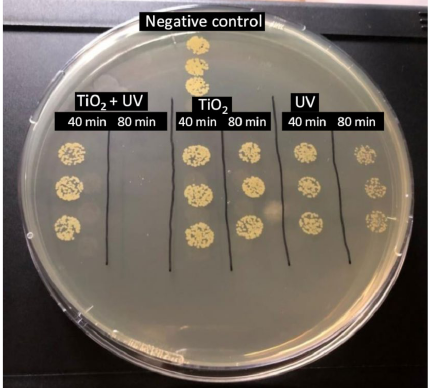
Fig. 6 M. luteus capability to form colonies determined by DP method. Obtained results after overnight incubation at 37